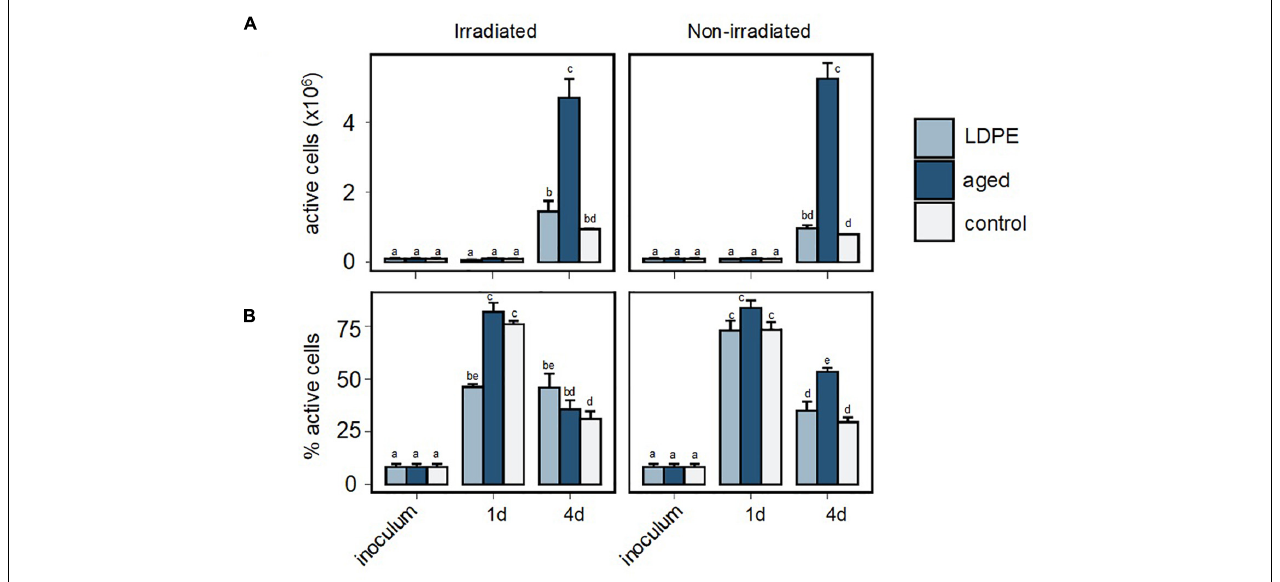
FIGURE 5 | Bacterial single-cell activity estimated with BONCAT in the inoculum and during the incubation with plastic leachates on day 1 and 4. (A) Number of active cells in the incubations. (B) Proportion of active cells. Different letters indicate significant differences among treatments. Error bars represent the standard deviation of the mean of the triplicate